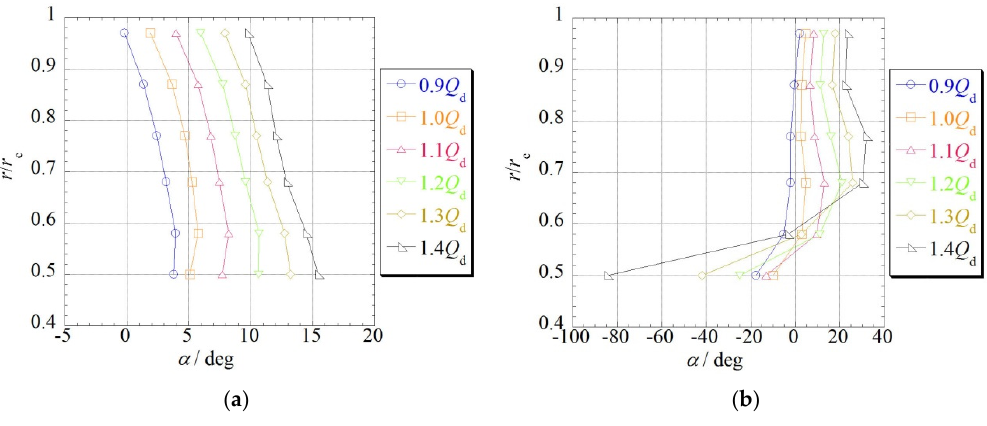
Figure 12. The attack angle of new model: ( a ) Upstream the front rotor; ( b ) Upstream the rear